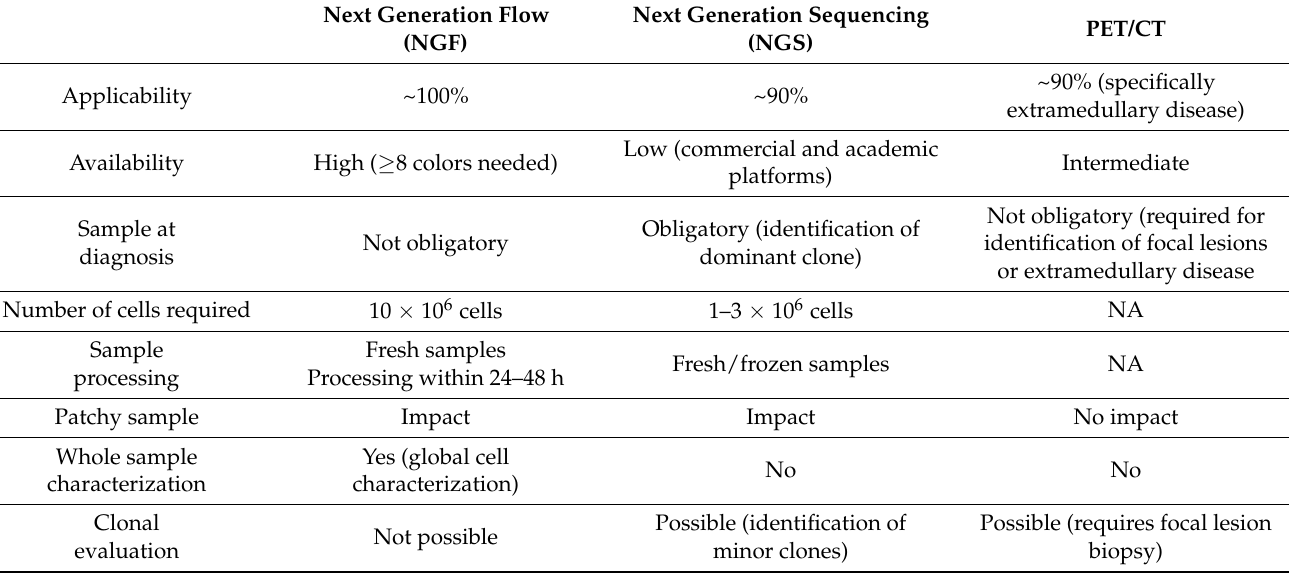
Table 1. Characterization of currently available techniques for MRD evaluation in MM recommended by the